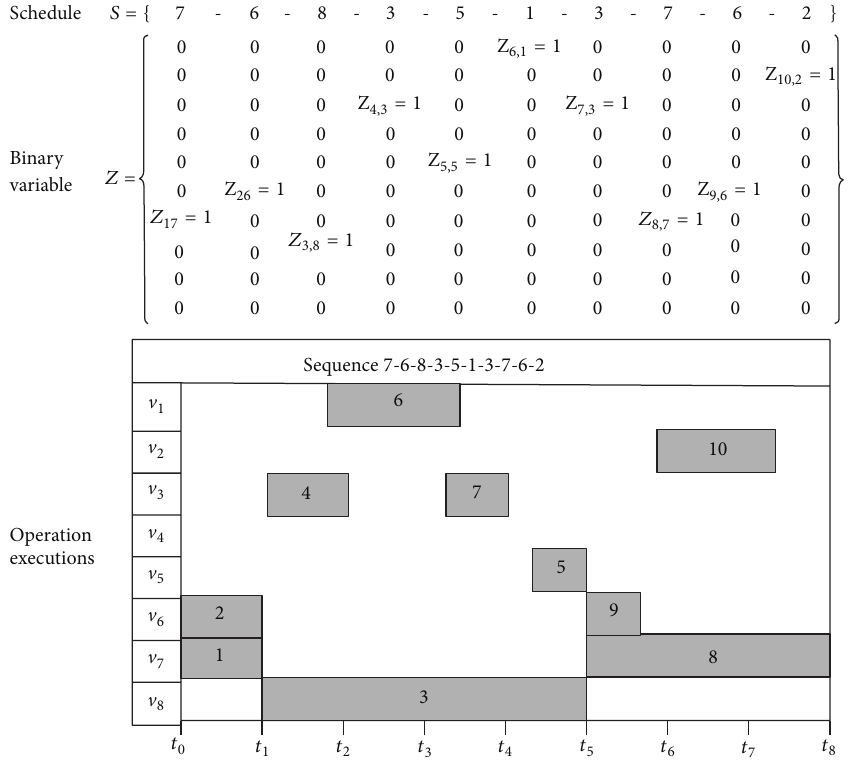
Figure 4: An example to indicate the relationship between binary variable and